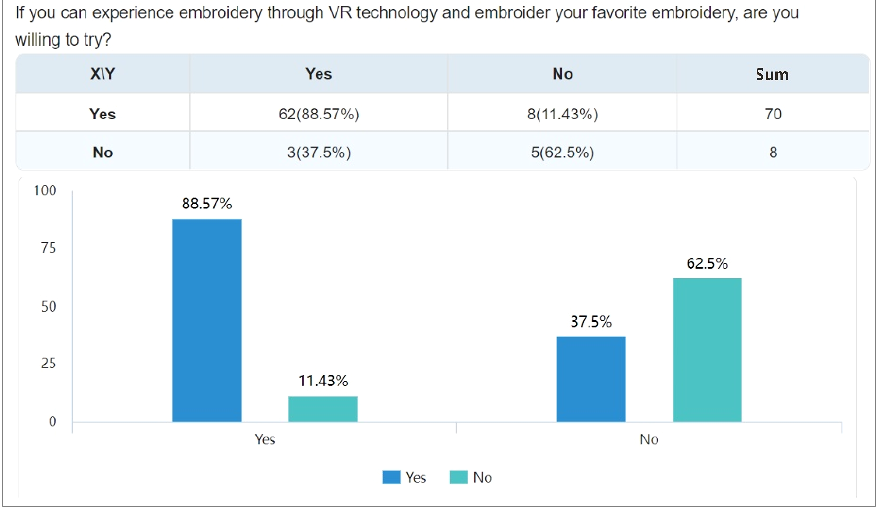
Figure 6. User survey data analysis